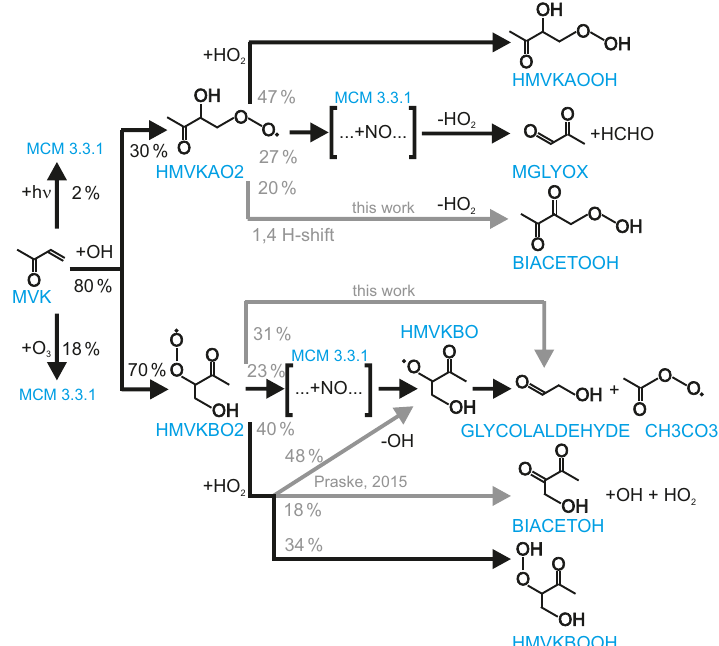
Figure 1. Simplified OH oxidation scheme for MVK. Names of compounds are assigned similar to MCM. Modifications to the MCM mechanism (M2) applied in model sensitivity runs M1 and M2 (Table 1) are shown as grey arrows. Reaction yields are calculated for conditions of the experiment with low NO (high ozone concentrations) on 23 May 2017. Grey numbers refer to model run